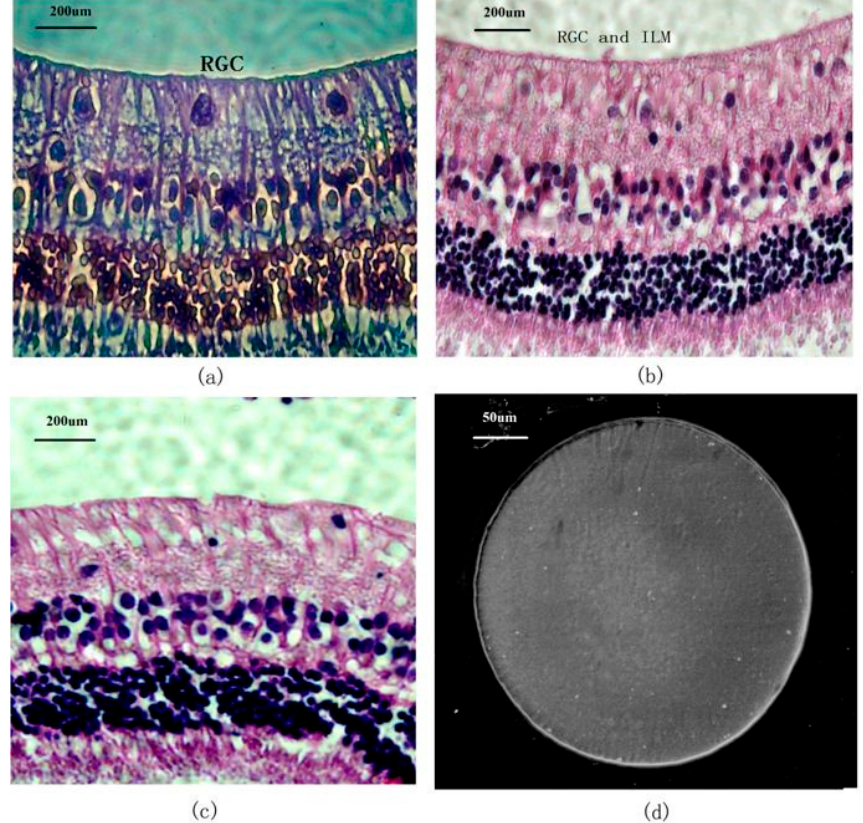
Figure 13. Long term in vivo biocompatibility evaluation of a microelectrode array based on photosensitive Durimide 7510 polyimide layer implanted within a rabbit eye: ( a ) phase-contrast image (400×) of the inner retinal morphology at 6 weeks post-implantation (RGC: retinal ganglion cell layer; ILM: inner limiting membrane); ( b ) light microscope image (400×) of the inner retinal morphology at 6 months post-implantation; ( c ) light microscope image (400×) of the control rabbit retina; ( d ) SEM micrograph of the undamaged implanted electrode at 6 months post-operation. Reproduced from [41], with permission from © 2013 BioMed Central, under CC BY 2.0.